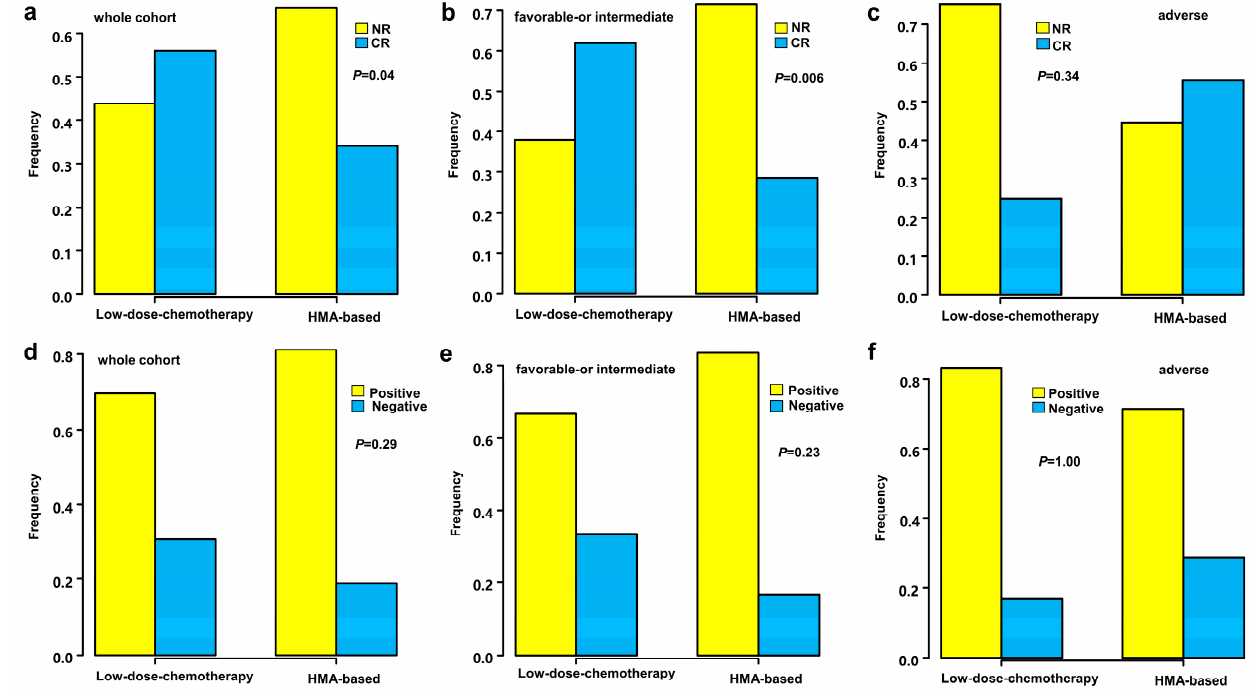
Figure 1. The CR/MRD after the first course of induction chemotherapy in the low dose-chemotherapy group and HMA-based group:( a ) CR for the whole cohort; ( b ) CR for favorable- or intermediate-risk patients; ( c ) CR for adverse-risk patients; ( d ) MRD for the whole cohort; ( e ) MRD for favorable- or intermediate-risk patients; and ( f ) MRD for adverse-risk patients. Abbreviations: HMA-based, hypomethylating agents combined with low dose chemotherapy; CR, complete remis- sion; MRD, minimal residual disease; NR,